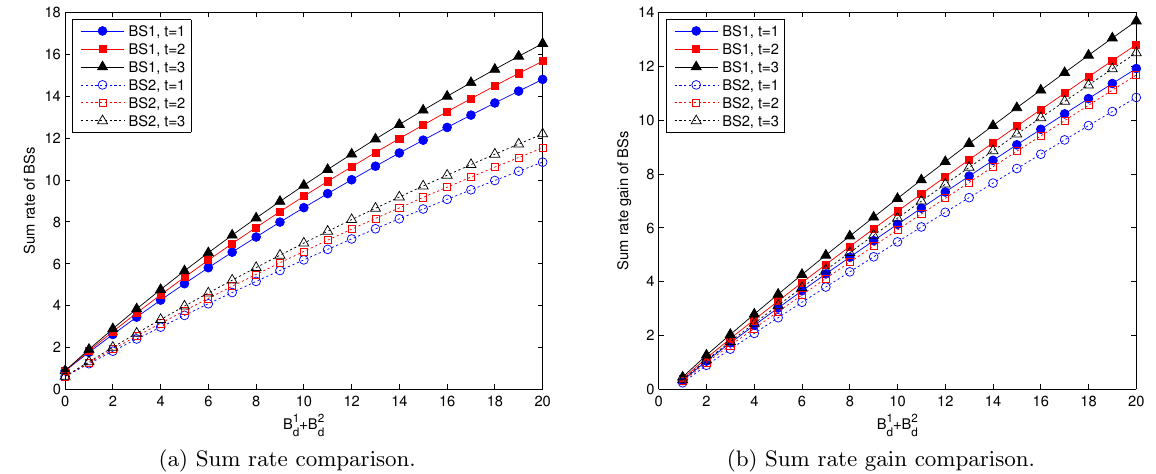
Figure 4: Performance comparisons for the first